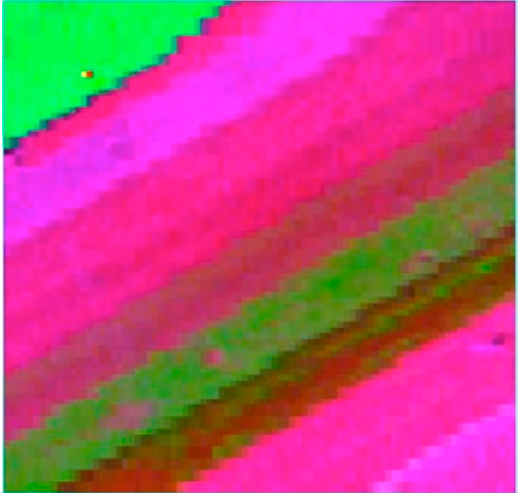
Figure 10. The false color composite image (15, 100 and 180 bands) of the Salinas-A scene dataset is a subset of the Salinas dataset that contained 224 spectral bands with a spatial resolution of 3.7 m and was acquired by the AVIRIS sensor over Salinas Valley, California, USA.